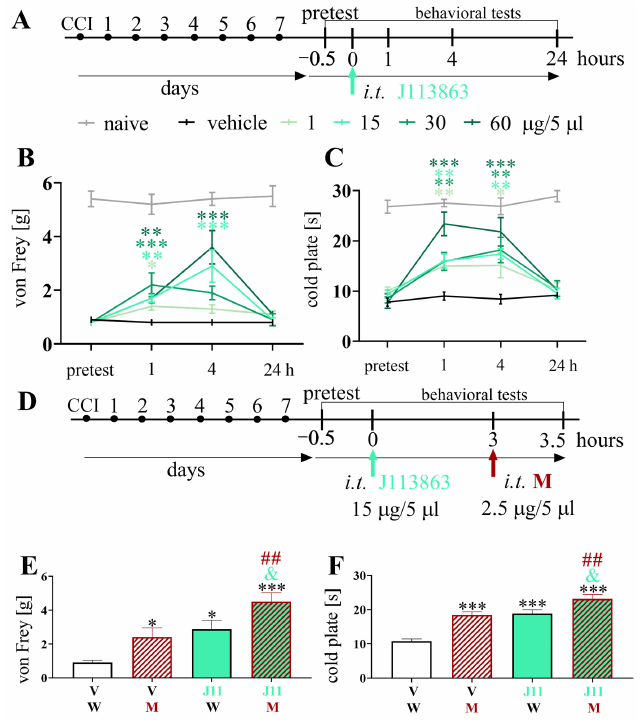
Figure 6 Figure 6. The effects of a CCR1 antagonist (J113863) administered intrathecally (i.t.) according to timeline ( A ), at doses of 1, 15, 30, and 60 µ g/5 µ L on mechanical ( B ) and thermal ( C ) hypersensitivity and the influence of J113863 at a dose of 15 µ g/5 µ L plus morphine 2.5 µ g/5 µ L on mechanical ( E ) and thermal ( F ) hypersensitivity, administered according to timeline ( D ), 7 days after CCI in mice. The data are presented as the mean ± SEM (naive n = 5; CCI n = 5–8). The results were evaluated using one-way ANOVA followed by Bonferroni’s post hoc test for comparisons of selected pairs. * p < 0.05, ** p < 0.01, and *** p < 0.001 indicate significant differences vs. V-treated group at each of the investigated time points: 1, 4, and 24 h for ( B , C ) graphs; * p < 0.05 and *** p < 0.001